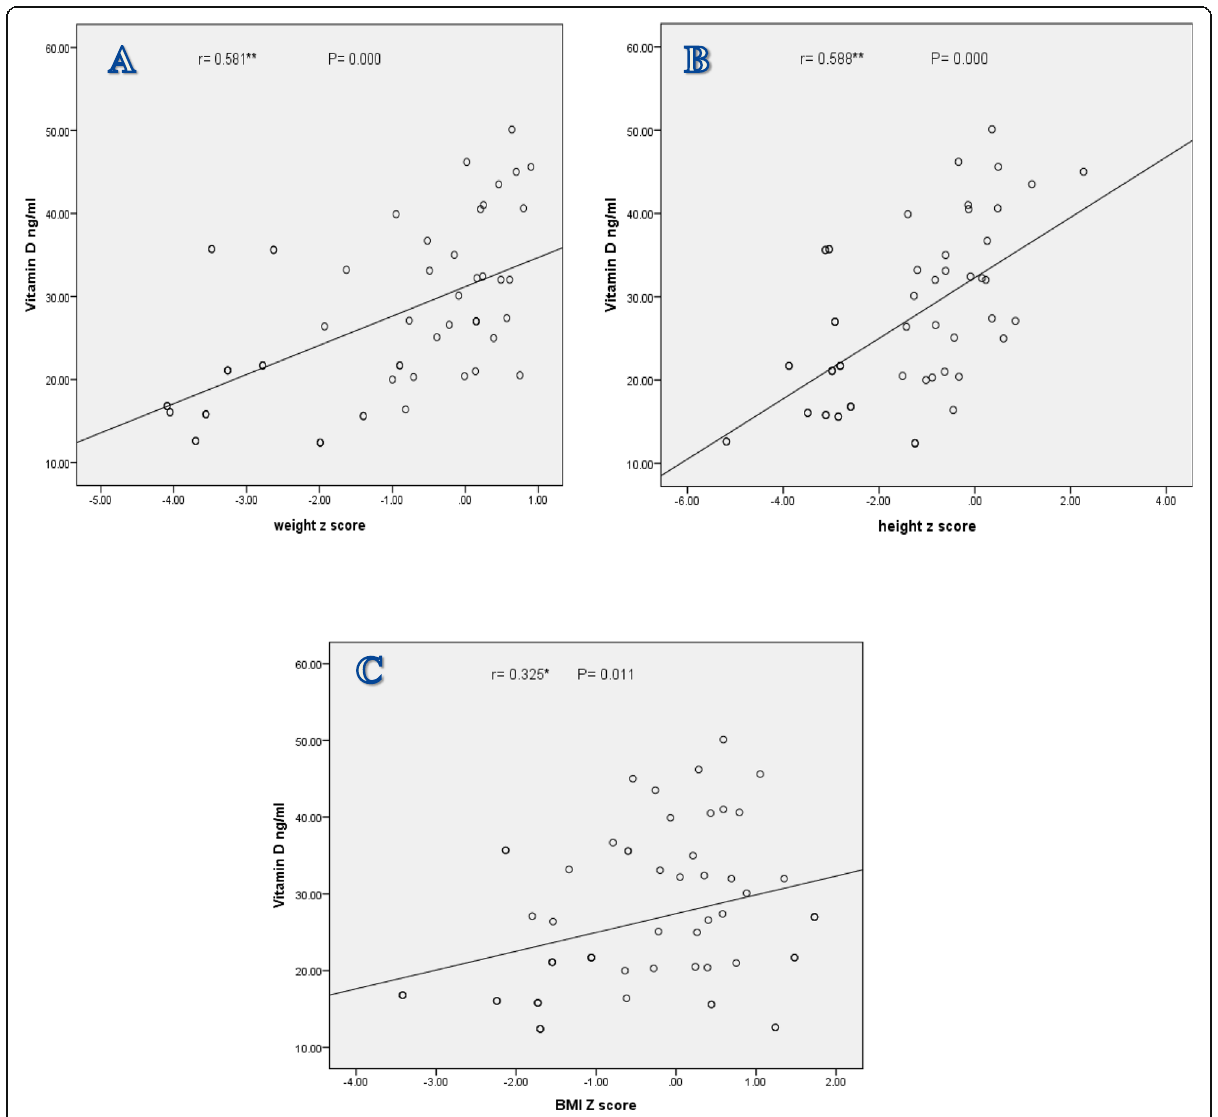
Fig. 1 Correlation of vitamin D level (ng/ml) with anthropometric measure Z scores ( a ) with weight Z score, ( b ) height Z score, and ( c ) BMI Z